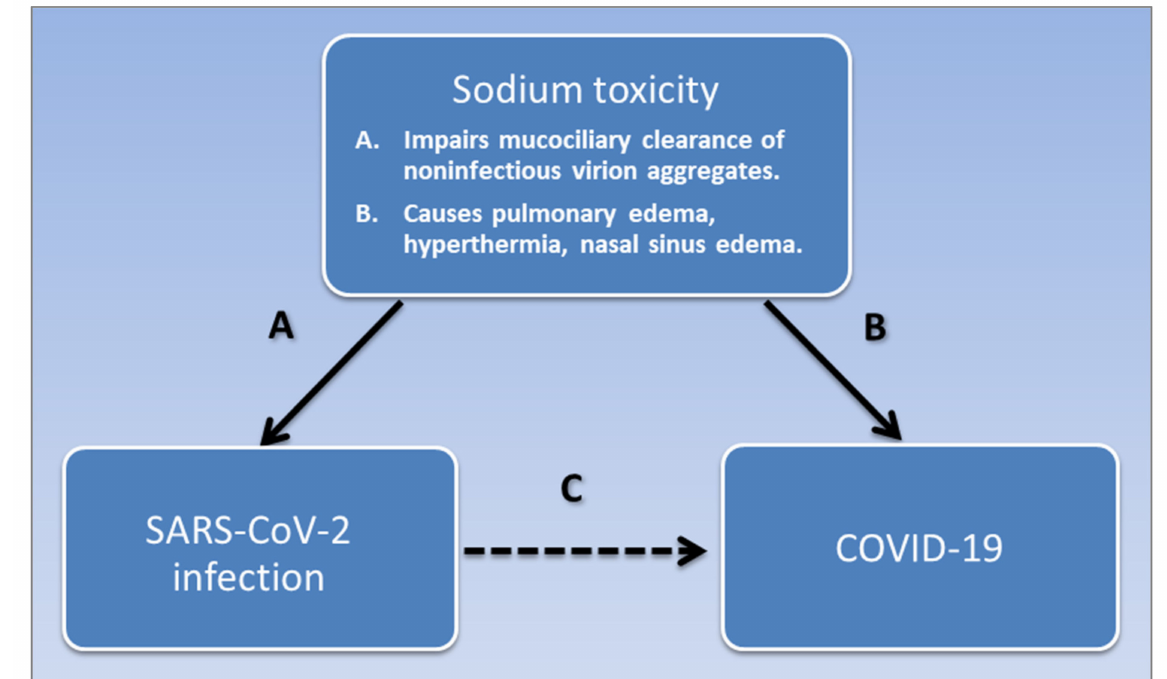
Figure 2. Sodium toxicity potentially mediates the association of SARS-CoV-2 infection and COVID-19. SARS-CoV-2 is associated with COVID-19, shown in pathway C . Sodium toxicity is a common causative factor that impairs the mucociliary clearance of noninfectious virion aggregates in the nasal mucosa, causing SARS-Cov-2 infection, shown in pathway A . Sodium toxicity also causes pulmonary edema, hyperthermia, and nasal sinus edema in COVID-19, shown in pathway B . Pathway A is potentially weak or absent in post-acute COVID-19 syndrome, and pathway B is potentially weak or absent in asymptomatic